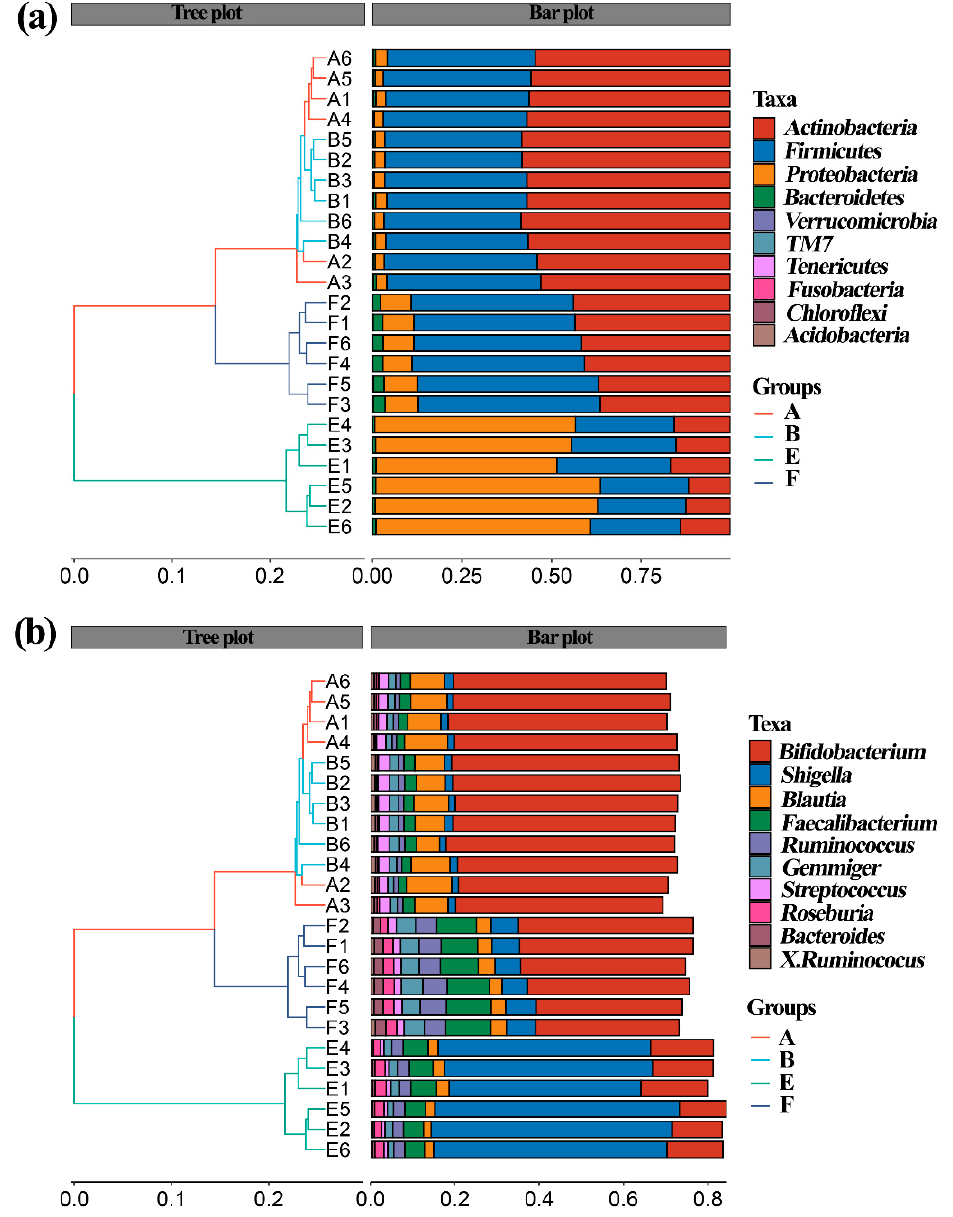
Figure 8. Effect of ZnONP on classification and composition diagram of gut bacteria at levels of ( a ) phylum and ( b ) genus. A: healthy children; B: healthy children + ZnONP; E: ASD children; F: ASD children +